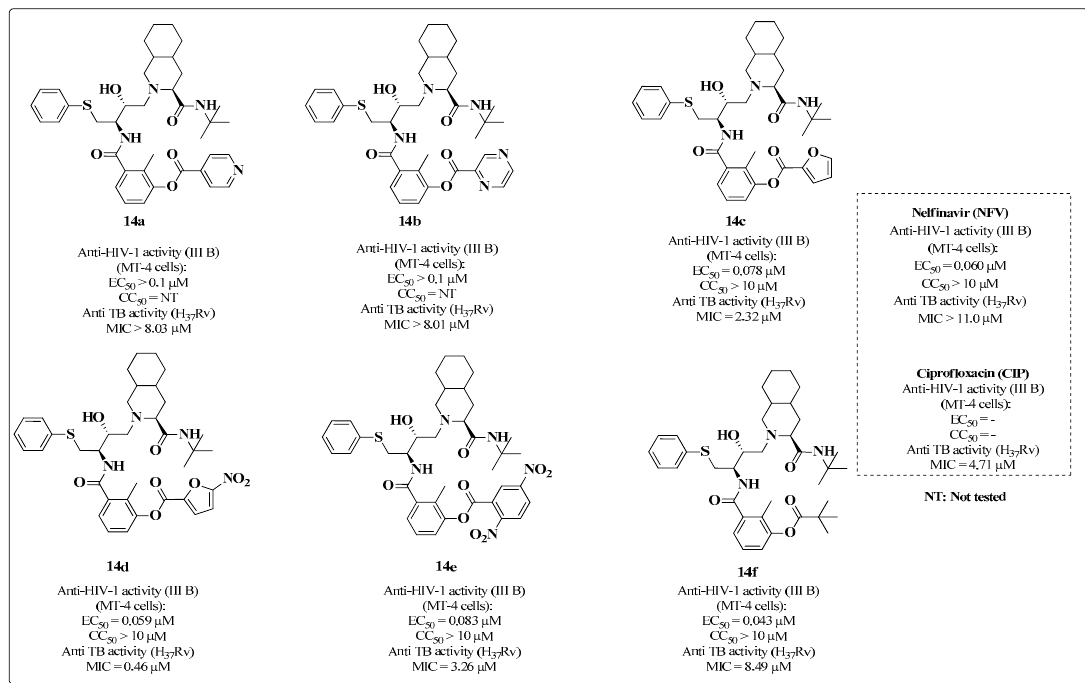
Figure 13. Anti-HIV and anti-MTB activities of NFV-derived compounds [92].